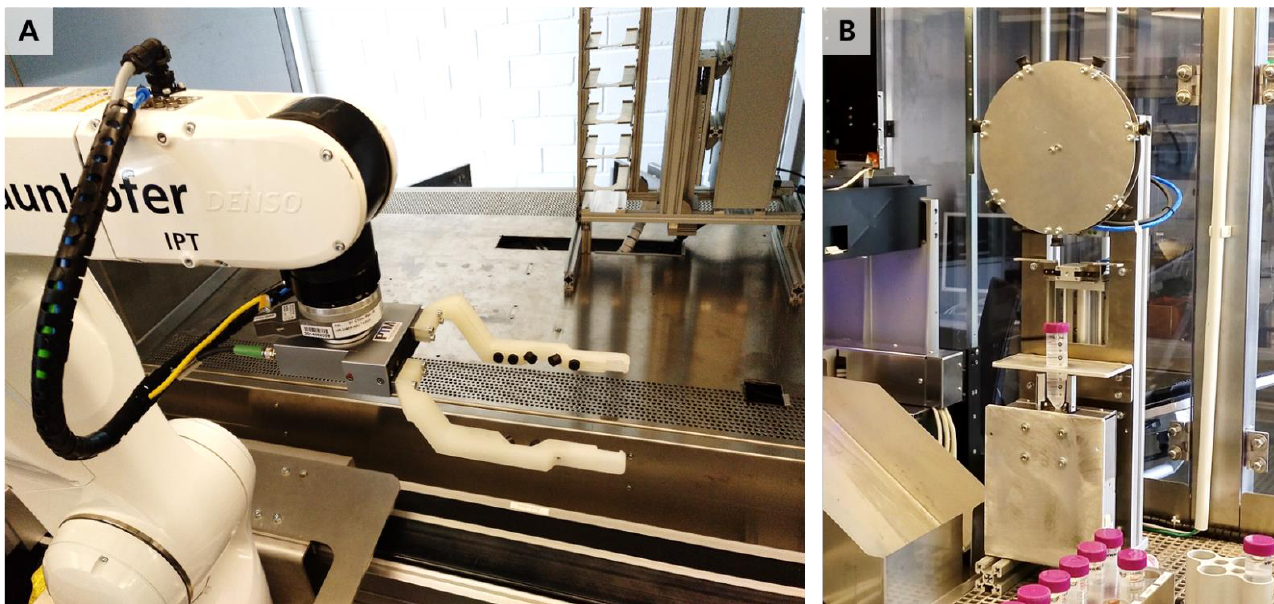
Figure 2. Devices in the StemCellDiscovery platform [13] with ( A ) the robot and its motor-driven gripper and ( B ) the decapper to automatically open and close screw caps.